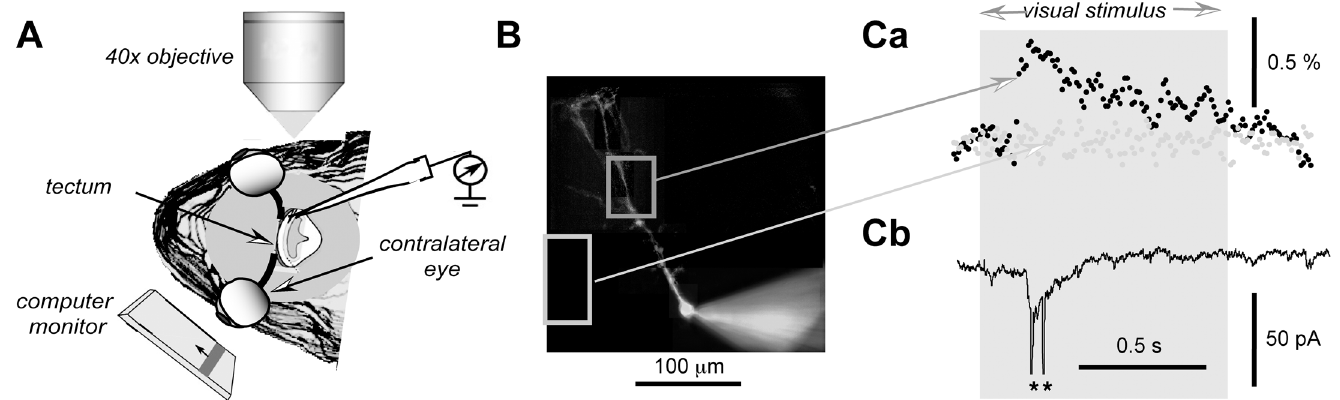
Fig 1. Experimental set-up for recording of dendritic calcium concentration changes during visual stimulation. A . A schematic representation of the frog head placed under 40x long working distance objective for fluorescence imaging of patch-clamped neurons in the frog optic tectum. The visual stimulus was presented on the computer monitor located on the other side than the recorded neuron. B . A stack of 15 images at different focus depth was used to reconstruct this picture of a typical layer 6 neuron recorded in the frog optic tectum. Light grey squares represent areas used for calculation of the time-course of the fluorescence intensity shown in Ca . Ca represents two fluorescence intensity traces obtained during visual stimulus, a 1 s long dimming of the monitor, indicated by light grey background. Black filled circles represent the proximal dendritic branches of a neuron shown in B light grey filled circles represent a background trace obtained from the area with no dendritic branches of the recorded neuron. Here, to facilitate the comparison with the background trace, both the proximal dendrite the background fluorescence signals were normalized to the overall baseline fluorescence, background plus signal. Meanwhile in Figs 3 and 4 the fluorescence signal was normalized only to the image signal as shown in Fig 2. Cb represents currents recorded from the same neuron during visual stimulation. The asterisks mark currents generated by action